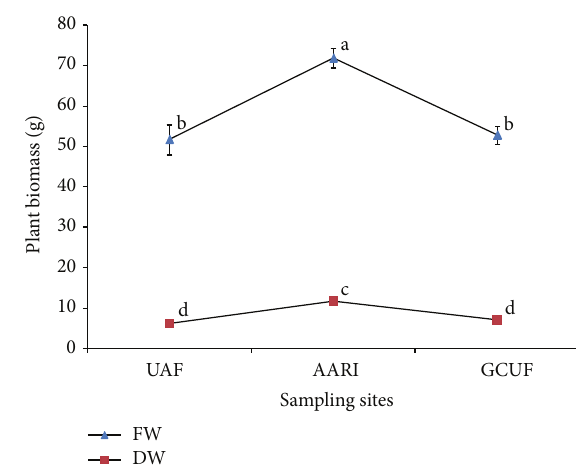
Figure 3: Shoot biomass (fresh and dry weights) of calendula plants collected from semiarid zone. Values ( 𝑛 = 9 ± SE) with different superscripts (a–d) are significantly different at 𝑃 < 0.05